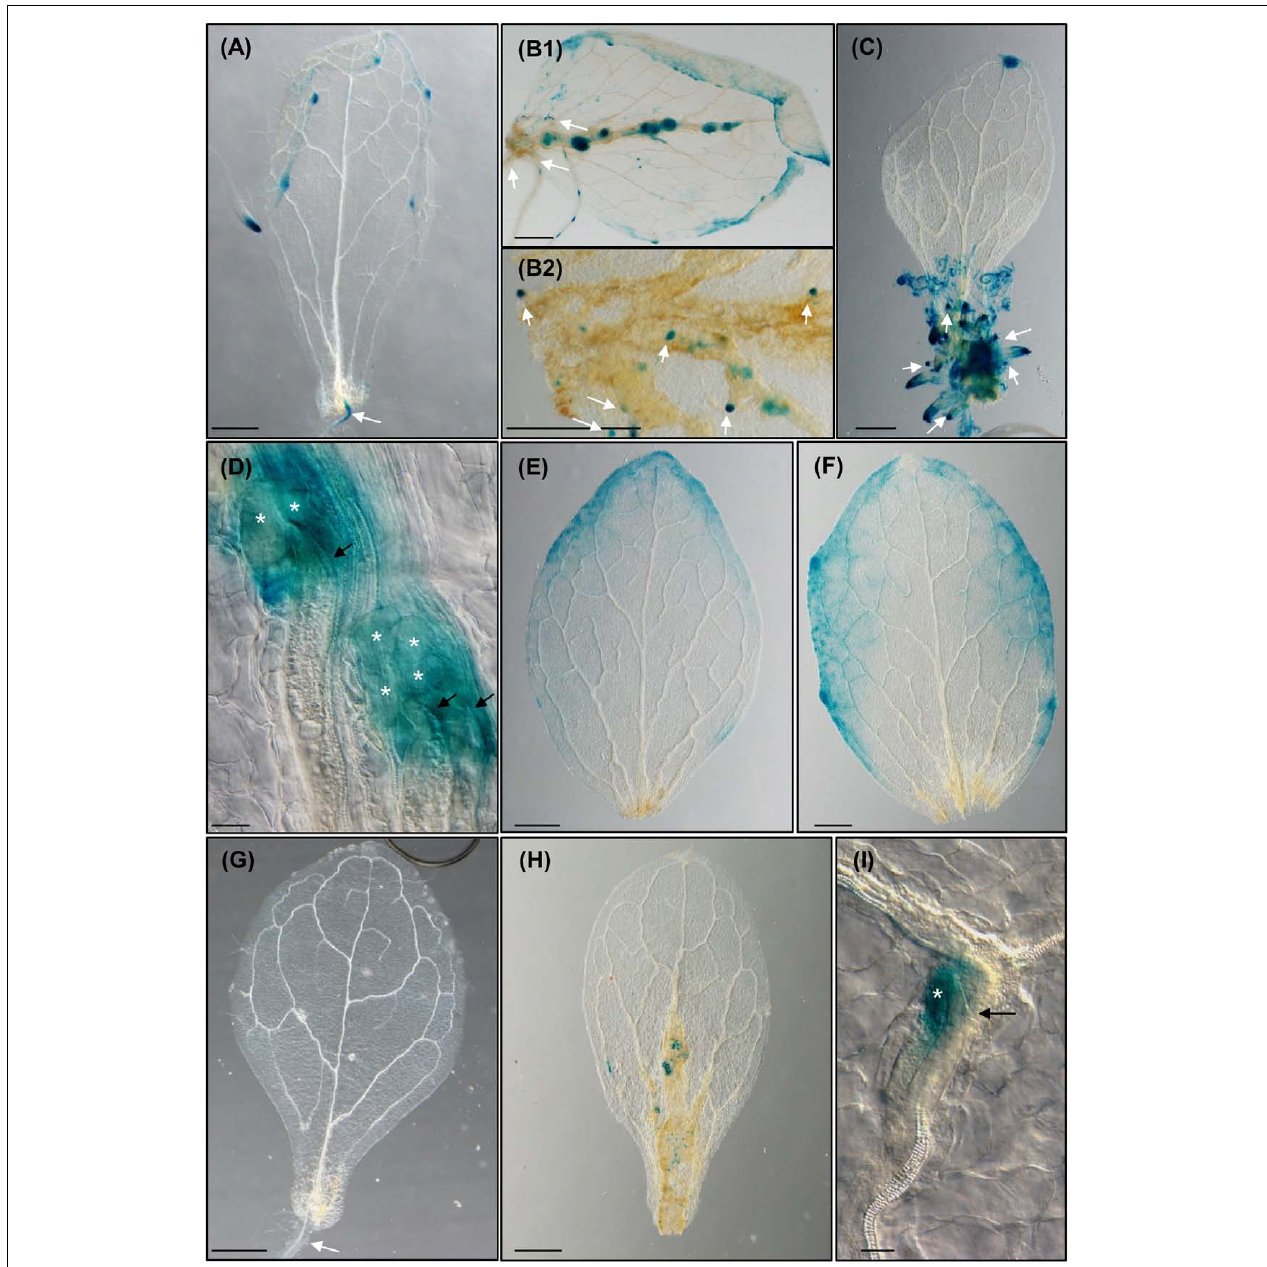
FIGURE 4 | The formation of Meloidogyne javanica induced callus in Arabidopsis thaliana leaves is dependent on the accumulation of auxins transported from the leaf and activates G2-M cell cycle transition. (A) Arabidopsis leaves from the reporter line DR5::GUS cultured in Gamborg B5 medium supplemented with 3% sucrose, in the absence of any additional phytohormones, at 8 dac. (B) Arabidopsis leaves from the reporter line DR5::GUS cultured in Gamborg B5 medium supplemented with 3% sucrose, in the absence of any additional phytohormones but inoculated with M. javanica juveniles, at 10 and 12 dac and inoculation (daci; B1 and B2, respectively). Numerous growing callus-like structures along the vascular cylinder express GUS; emerging ARs primordia expressing GUS from the callus-like structures are also observed (B2). (C) DR5::GUS leaf explant when cultured in Gamborg B5 implemented with 3% sucrose containing 0.1 µ M of exogenous IAA at 8 dac, calli in the excision area and emerging ARs observed express GUS. (D) Close up view of the nematode feeding cells in leaves treated as in (B) . DR5::GUS leaf explants uninfected (E) or infected (F) by nematodes when cultured in Gamborg B5 implemented with 3% sucrose containing 1 µ M of NPA at 8 dac/daci; no calli neither ARs are observed. (G) Arabidopsis leaves from the reporter line ProCycB1;1:CycB1;1(NT)-GUS cultured in Gamborg B5 medium supplemented with 3% sucrose, in the absence of any additional phytohormones, at 8 dac. (H) Arabidopsis leaves and (I) close-up view from the reporter line ProCycB1;1:CycB1;1(NT)-GUS cultured in Gamborg B5 medium supplemented with 3% sucrose, in the absence of any additional phytohormones but inoculated with M. javanica juveniles, at 8 and 10 daci, respectively; groups of cells expressing GUS indicative of cells entering G2-M are clearly observed. Black arrows, white arrows and white asterisks indicate the nematode, the ARs and the GCs, respectively. N ≥ 45. Scale Bars: 500 µ m (A–C,E–H) and 100 µ m (D)